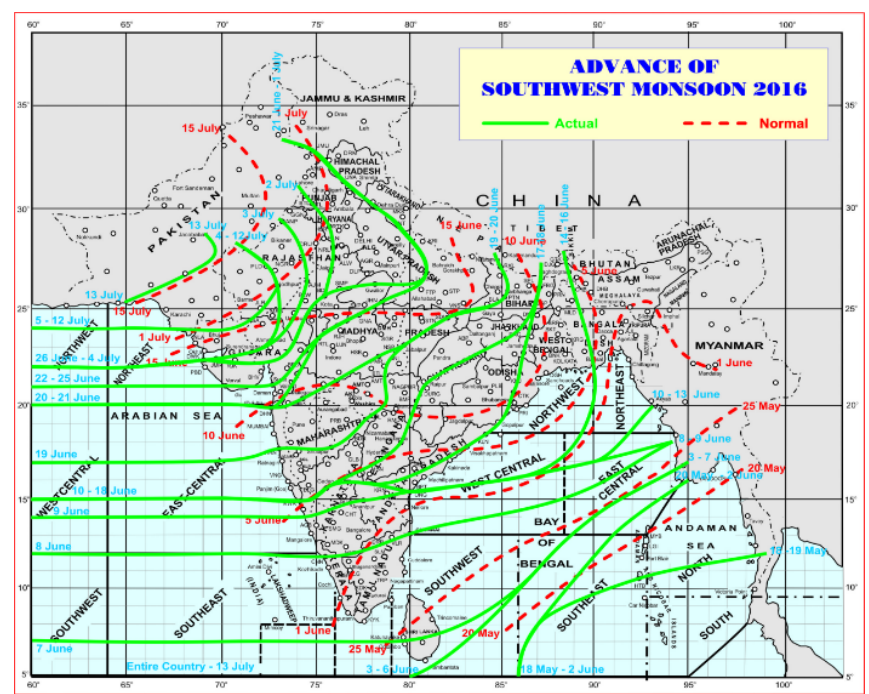
Figure A1. Advance of the Indian summer monsoon of 2016 (India Meteorological Department, Ministry of Earth Sciences, India).